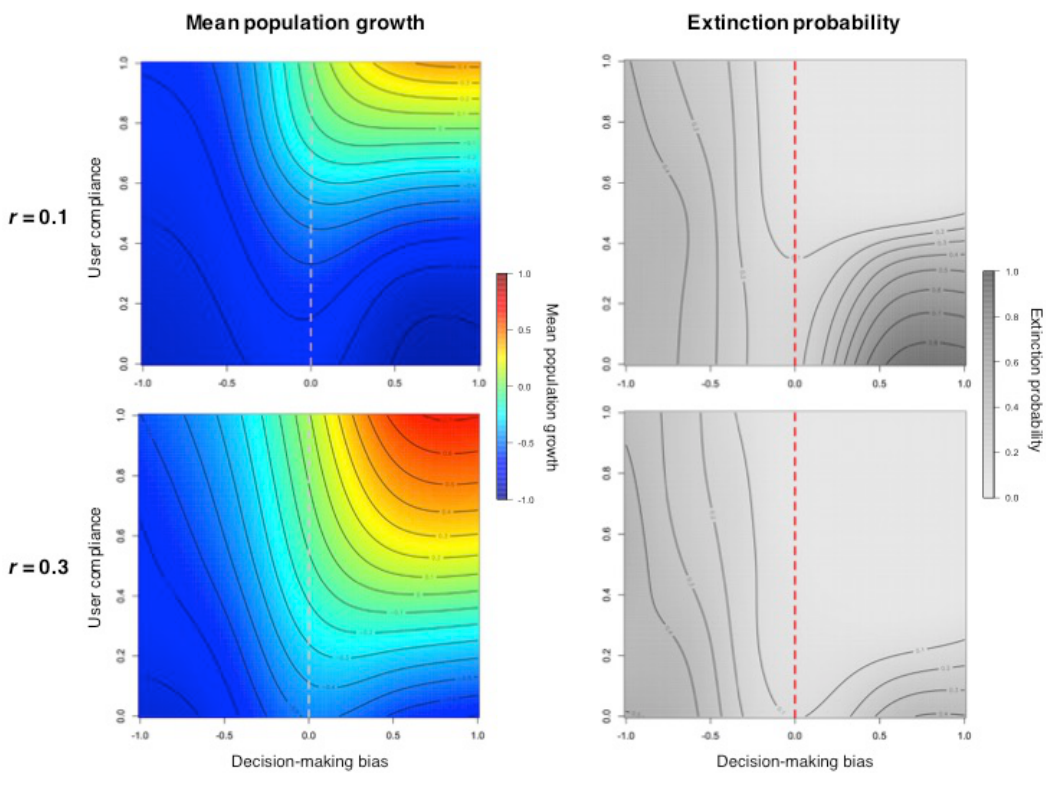
Fig. A5.1 . Mean population growth and extinction probability over a